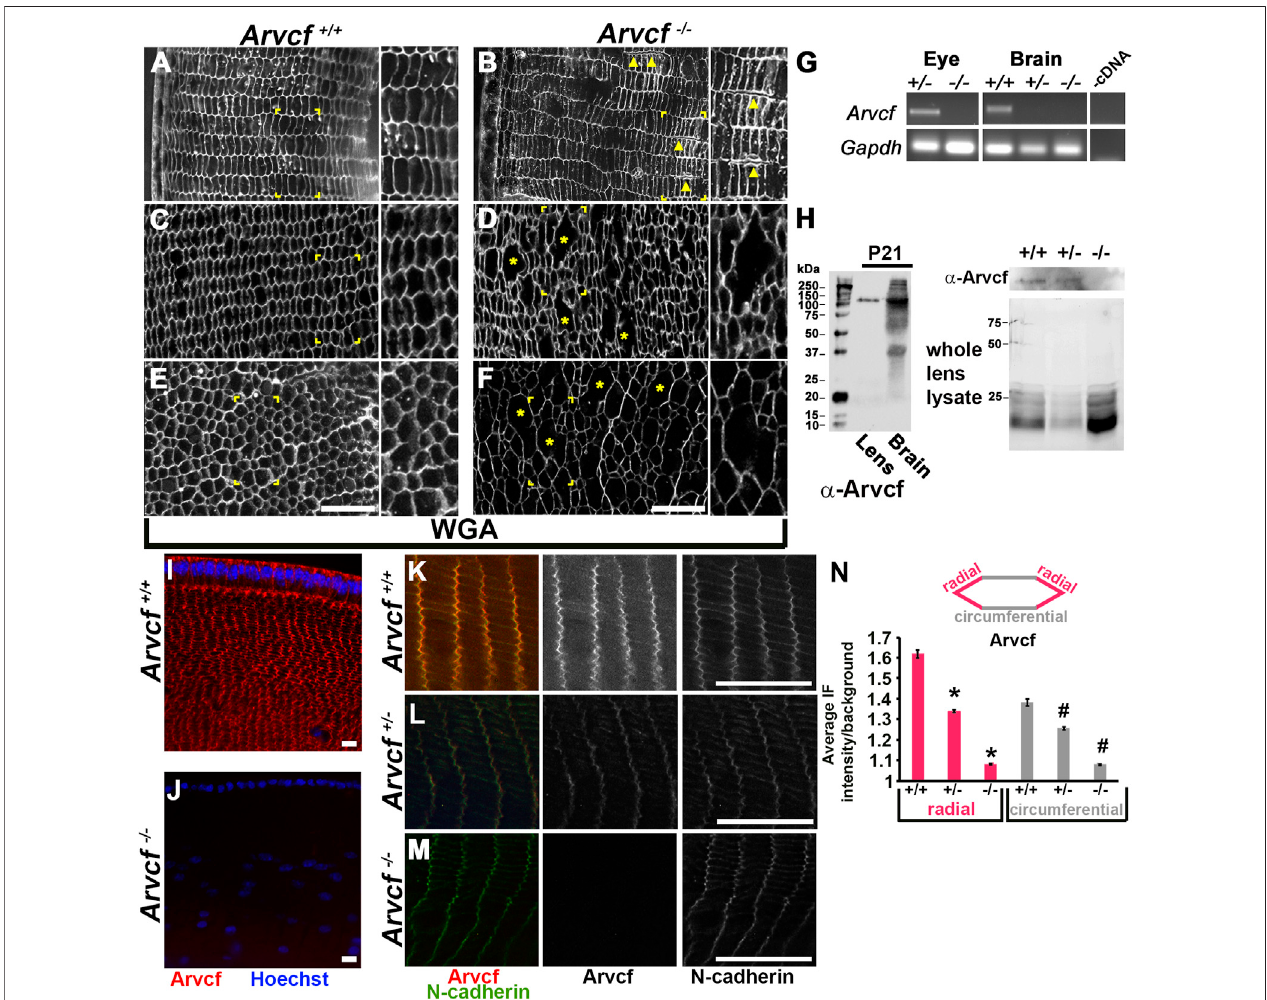
FIGURE 3 | Loss of Arvcf protein leads to disrupted lens fi ber cells and an increase in p120-catenin localization. (A – F) WGA immunolabeled (white) equatorial cryosectionsof30 day oldmouse lenses from animalswiththeindicatedgenotype. Magni fi ed images ofthe boxed region arefoundtothe right withineach panel. (C,D) are images taken ~300 microns from the lens surface and (E,F) are from near the lens nucleus. The yellow arrowheads point to examples of fi ber cells that are often observed separated from each other in Arvcf − / − lenses and the asterisks depict regions where either the membrane is not stained or possibly missing. (G) RNA isolated from the eye and brain of animals with the indicated genotype was subjected to RT-PCR using primers speci fi c to Gapdh and exons 3 and 4 of Arvcf . Exon 4 is predicted to be absent from the transcript due to the insertion of a polyadenylation signal site within intron 4 – 5. (H) An Arvcf-speci fi c antibody was utilized on western blots from control, heterozygous, and homozygous lens and brain lysates. Left: Aband near the predicted size ofthe longest isoformof Arvcf (105 kDa)wasdetected in thelensandthebrainoflysatesfromcontrolanimals.Right:WesternblotswiththeArvcfantibodyoflenslysatesfromeachgenotypeaboveanimageofthesamegelwith its totalprotein stained. (I – L) Images ofequatorial cryosections ofjuvenilemouselenses(P7)from Arvcf +/+ (I,K), Arvcf +/- or Arvcf − / − (L) animals immuno fl uorescently co- labeled for Arvcf (red) and nuclei (blue) (I) or Arvcf (red) and N-cadherin (green). (N) Fluorescent signal intensity was measured along the junctions labeled radial or circumferential as depicted in the diagram. The graph represents the normalized mean intensity of Arvcf signal along each junction orientation. Asterisks and # symbols represent a signi fi cant difference from the control group ( p < 0.05). A Plan-Apochromat ×40/1.3 Oil objective with wide- fi eld fl uorescent microscope was utilized. The scalebar is 25 μ